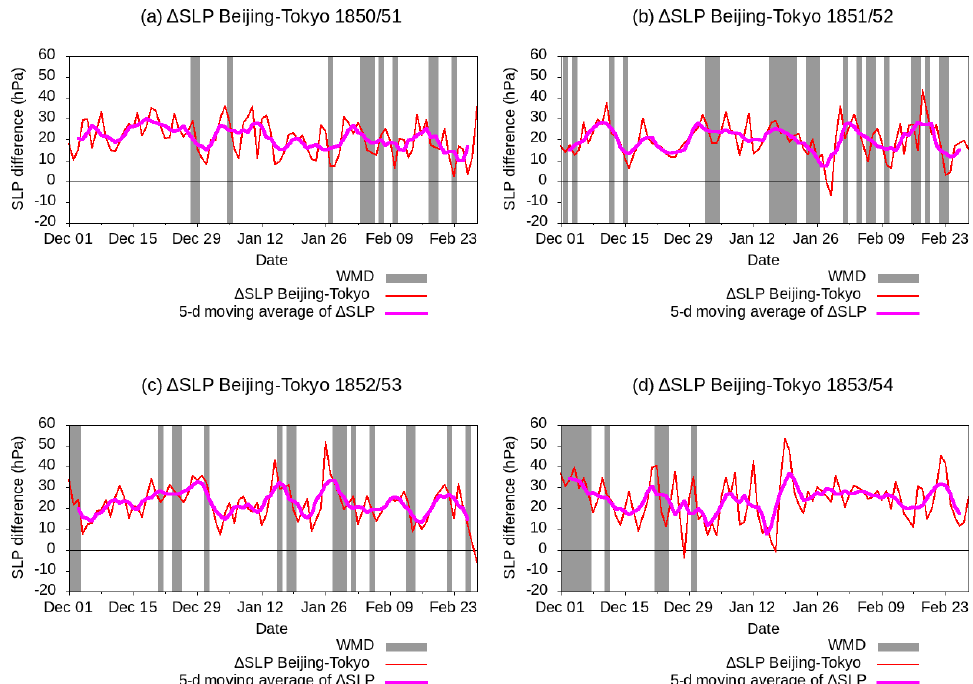
Figure 13. Temporal variations in surface pressure differences between Beijing and Tokyo ( (cid:49) SLP B–T) and winter monsoon outbreak days (WMDs) for (a) 1850/51, (b) 1851/52, (c) 1852/53, and (d) 1853/54.